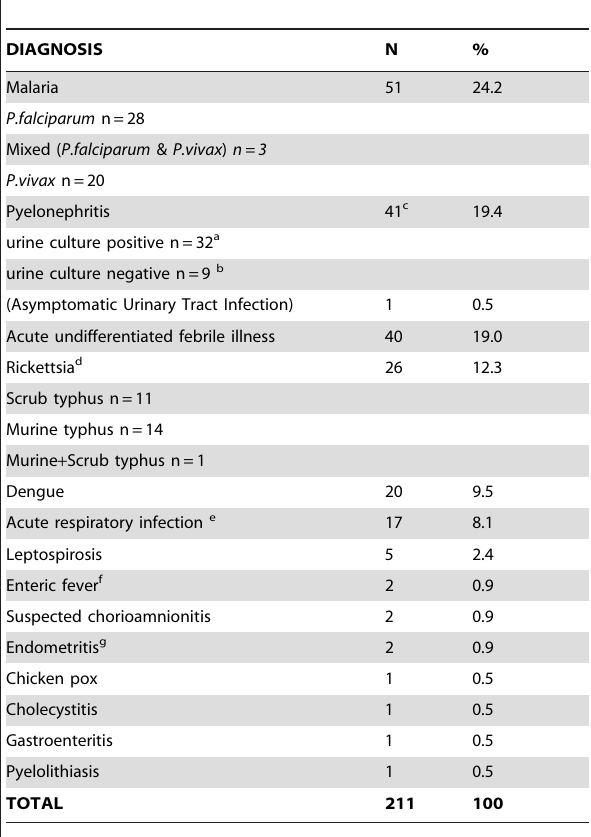
Table 2. Number of diagnoses (N =211) in pregnant women (N= 203) with